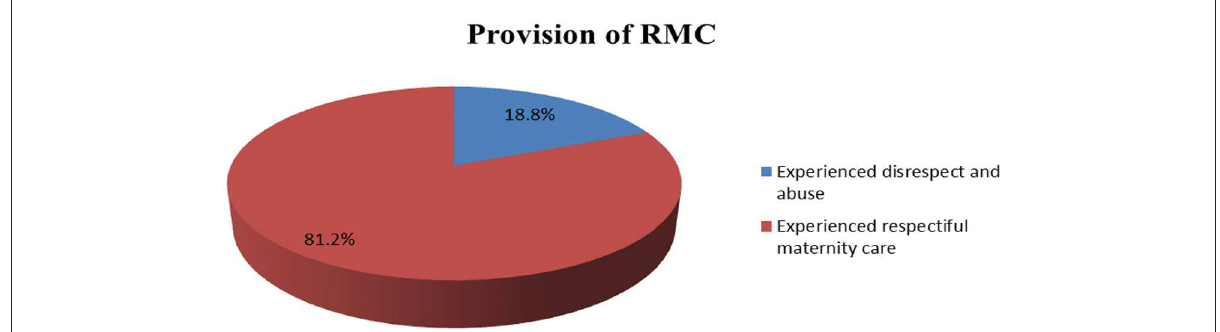
FIGURE1 Provision of RMC during labor and delivery in three public hospitals of Southwest Ethiopia ( n = 348).